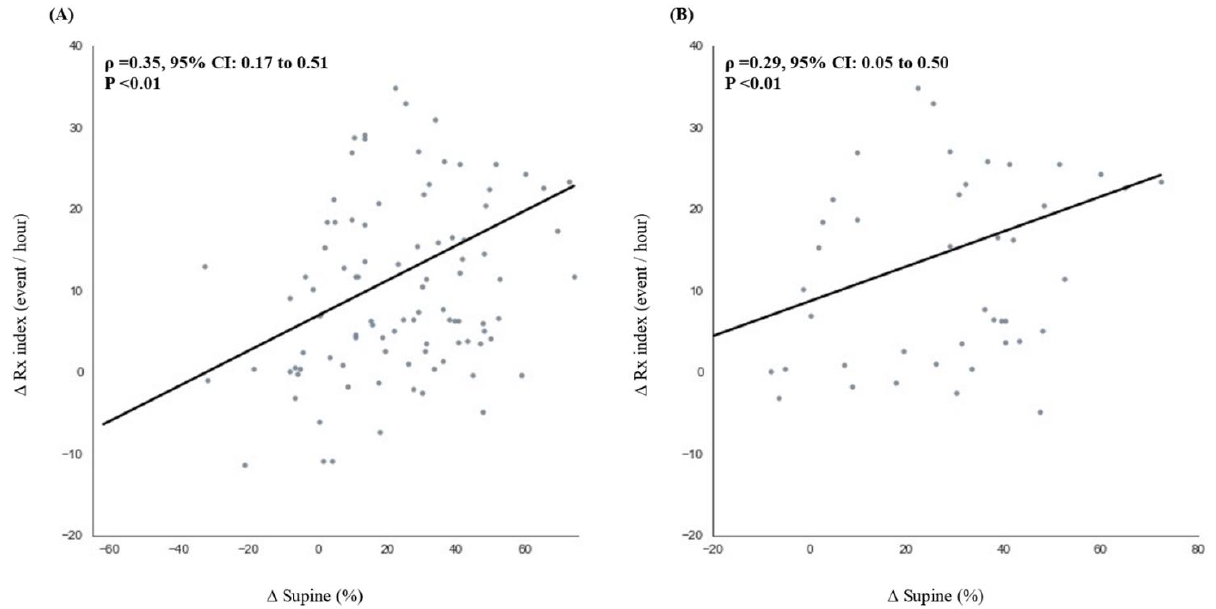
Figure 5. Correlations between the variations between hospital- and home-based measurements of the percentage of supine sleep time and the RootiRx parameters in the high-sleep-efficiency groups: ( A ) correlation between the variations in the percentage of supine sleep time and Rx index values in patients with a sleep efficiency of ≥ 80% ( n = 103); ( B ) correlation between the variations in the percentage of supine sleep time and Rx index values in patients with a sleep efficiency of ≥ 90% ( n = 46). Abbreviations: Rx index, combination of the cyclic variation of heart rate index and the chest effort index.